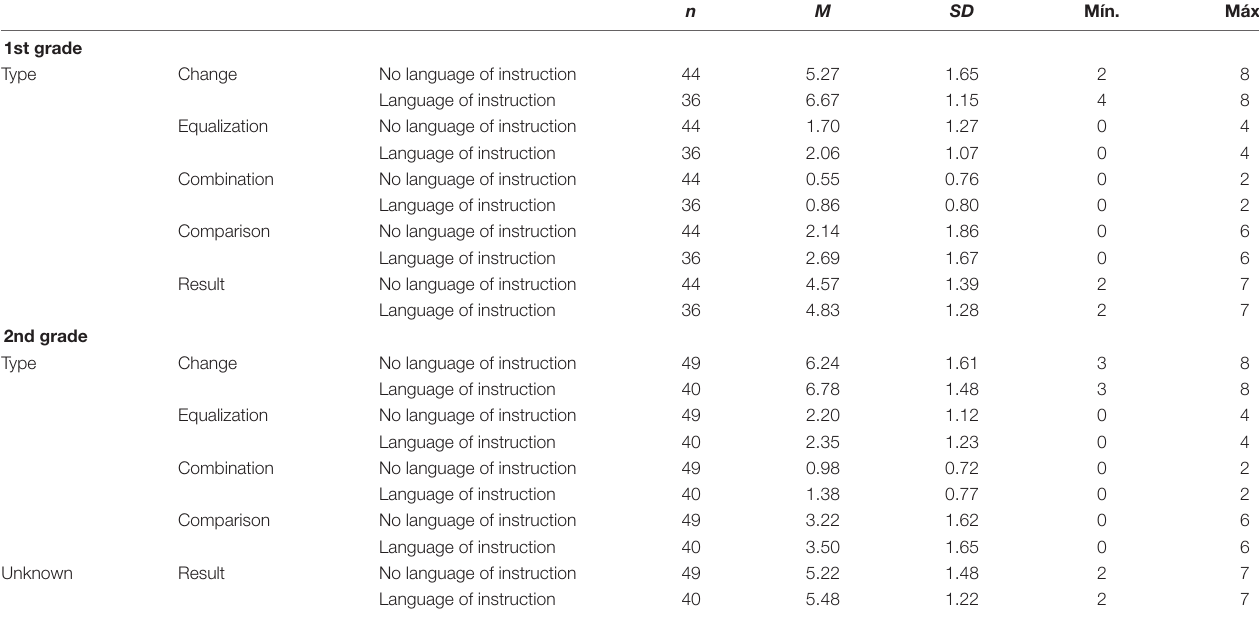
TABLE 1 | Descriptive statistics by language coincidence (yes/no) (M, mean; SD, standard deviation).